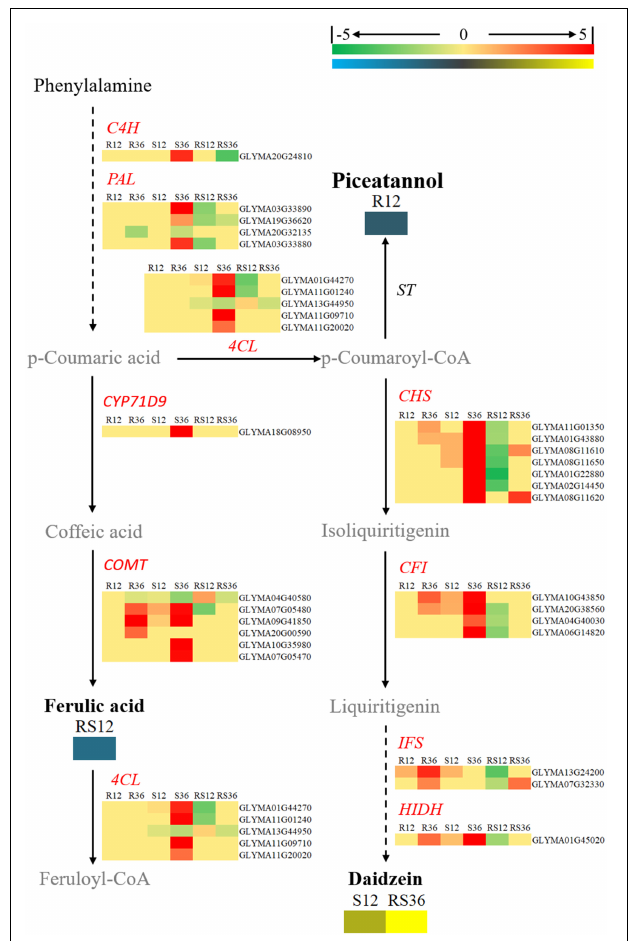
FIGURE 7 | Diagram of a branch of the isoflavonoid biosynthesis pathway with its related DEGs and DAMs. DAMs are in bold black fonts. No significantly differentially accumulated metabolites are in black fonts, unidentified metabolites are in gray fonts, and the abbreviations of gene names are in italics. The log 2 Foldchange was colored using Cluster 3.0 (red for upregulated DEGs, green for downregulated DEGs, yellow for upregulated DAMs, blue for downregulated DAMs), and the vertical columns represent R12, R36, S12, S36, RS12 and RS36, from left to right. R12: R-12h-IN vs. R-12h-CK; R36: R-36h-IN vs. R-36h-CK; S12: S-12h-IN vs. S-12h-CK; S36: S-36h-IN vs. S-36h-CK; RS12: R-12h-CK vs. S-12h-CK; and RS36: R-36h-CK vs. S-36h-CK. IN, inoculated; CK, control check. A color bar is in the upper right corner. Abbreviations of gene names are listed in Supplementary Excel S4